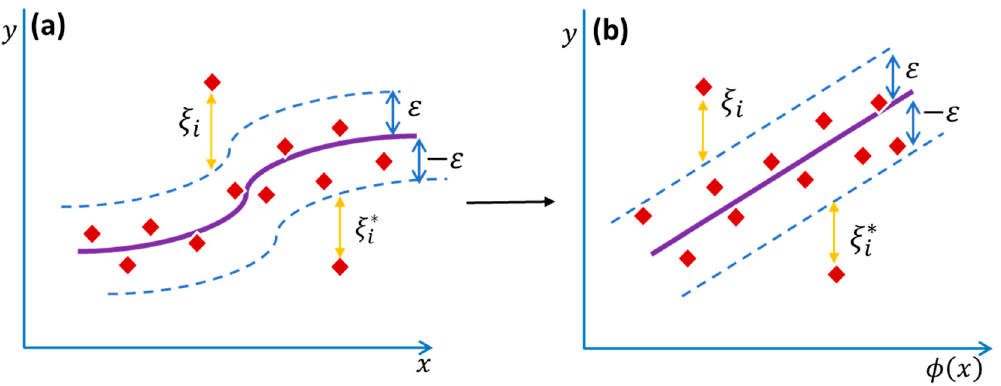
Figure 3. Support vector regression for non-linear response modelling from ( a ) higher dimensional domain to ( b ) lower dimensional domain.